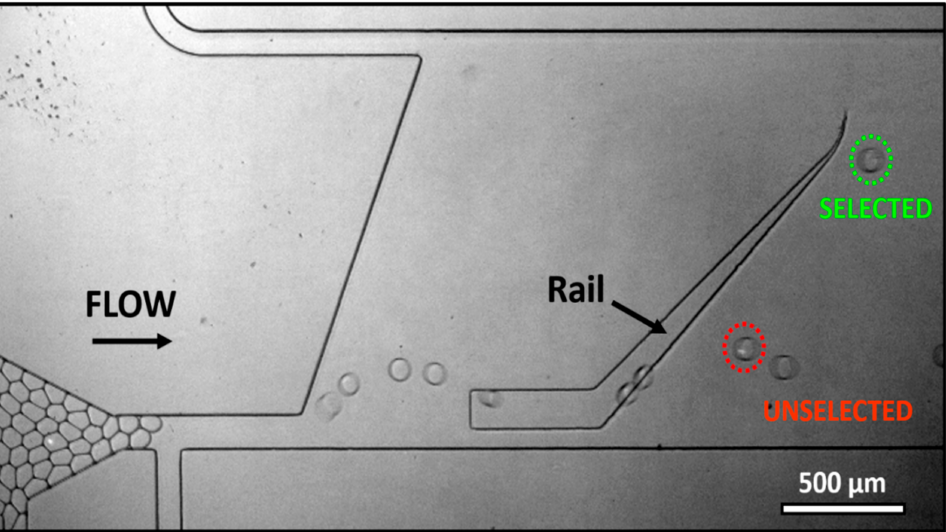
Figure 3. SIFT device sorting of activated and naive Jurkat T-cells. A droplet containing an activated cell (circled in green), at pH 7.10, rides the trench laterally up (selected). A droplet containing a naive cell (circled in red) with higher pH, pH 7.19, is only slightly deflected by the rail (unselected). Empty droplets are also directed to the unselected chip